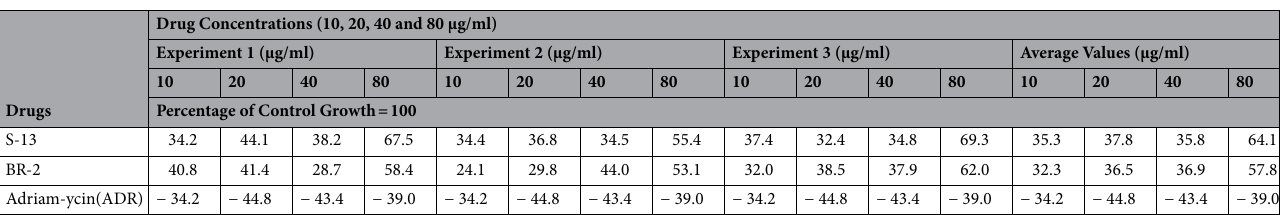
Table 2. Growth inhibition percentage at different dose concentrations of pectin on human hepatoma cell line